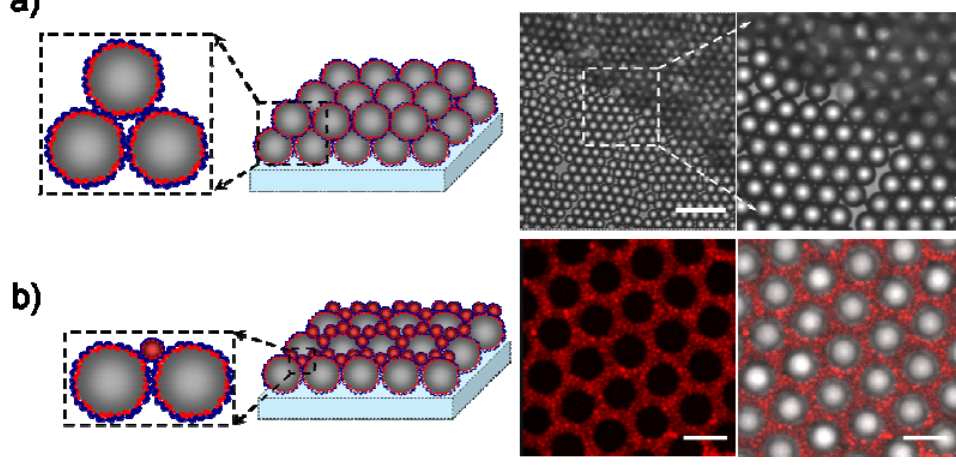
Figure 3. ( a ) Schematics (left) and top view in CLSM images (right) of a double layer self-assembly of PEM spheres. The right-hand side image shows an enlarged section of the middle panel. The scale bar corresponds to 20  m. ( b ) Schematics (left) and top view in CLSM images (right) of self-assembly of a smaller polyelectrolyte coated silica colloidal particle array into the spaces between larger spheres. Red fluorescence originates from PAH-TRITC labeling of smaller silica particles. The scale bars correspond to 5 